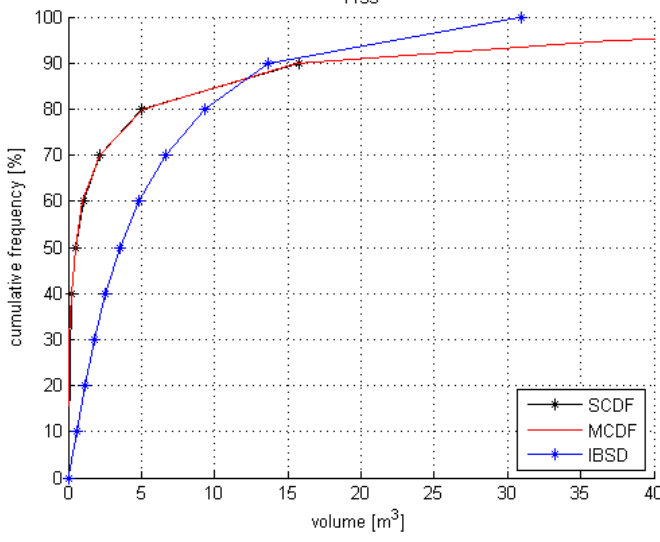
Figure 14. Comparison of block volume distributions obtained for term T135.